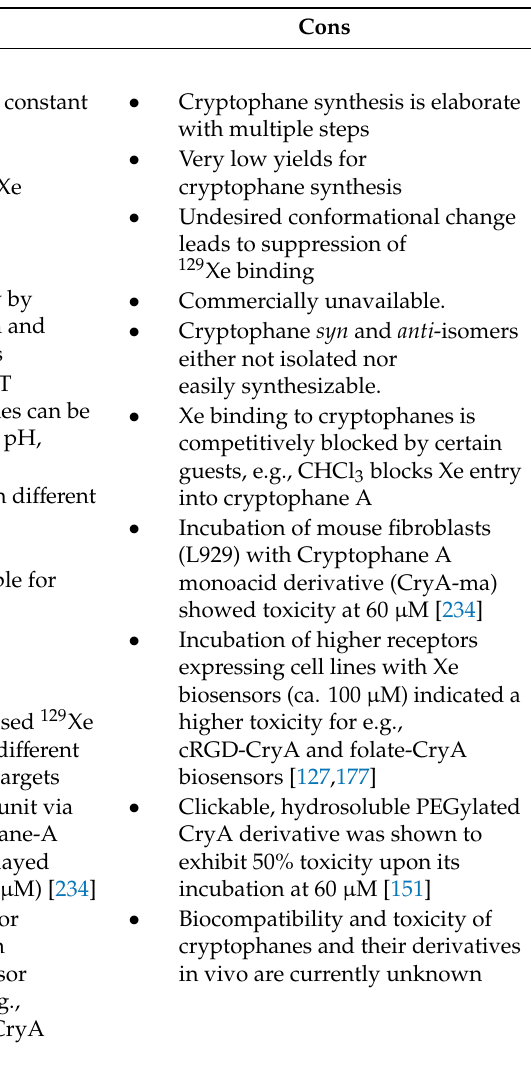
Table 1. Pros and cons of di ff erent hosts usage for 129 Xe molecular sensing applications. Host Pros Cons